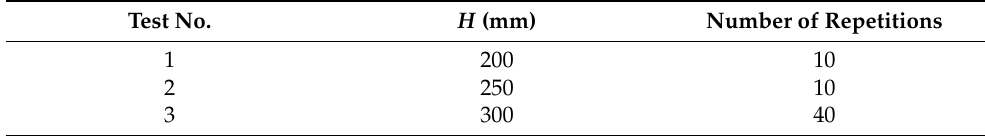
Table 1. Experimental tests and surge properties.